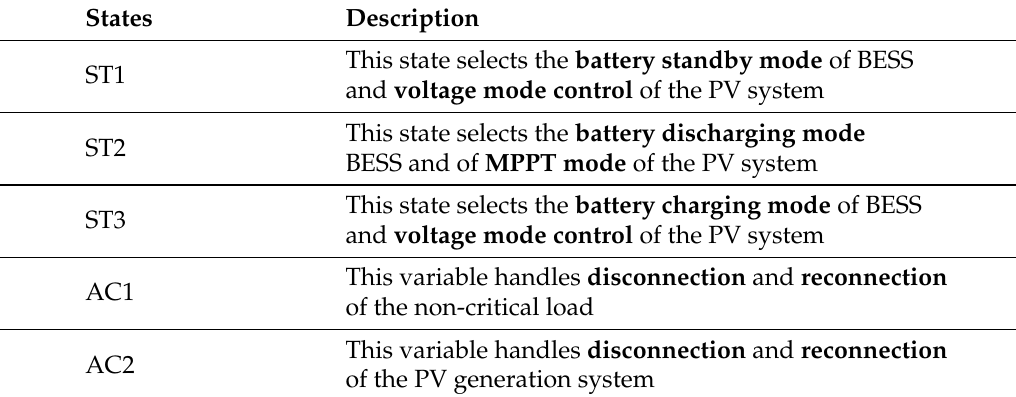
Table 1. Description of states and actions of the power management algorithm.